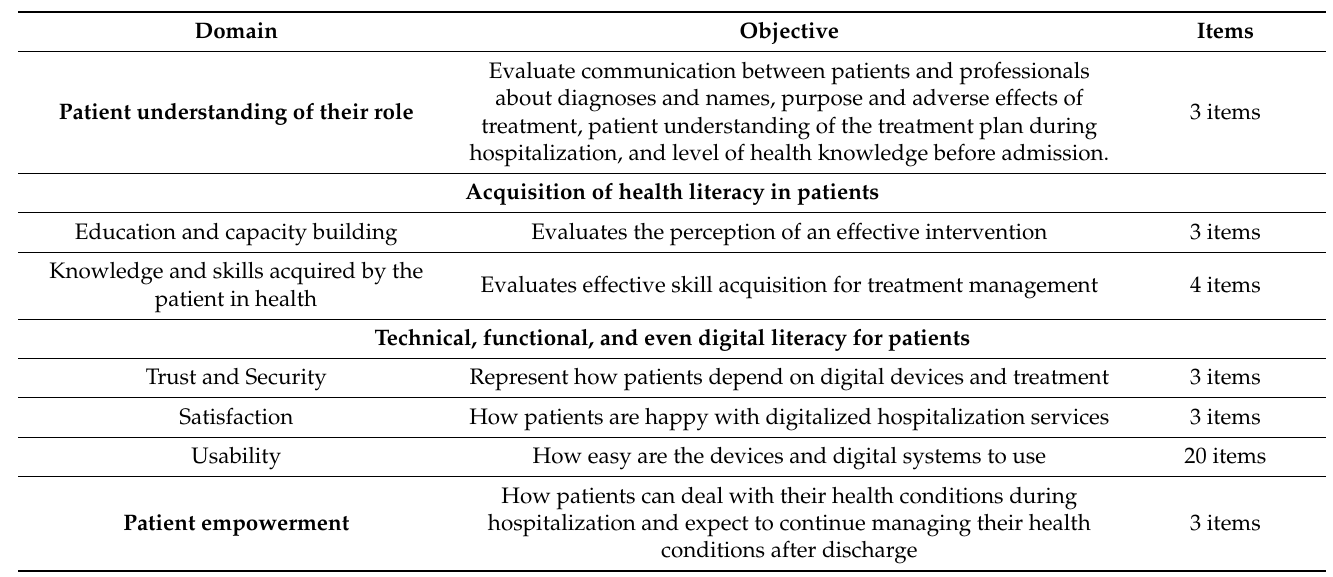
Figure 2. Conceptual framework to generate the Better@Home assessment questionnaire. Table 3. Survey measures completed by